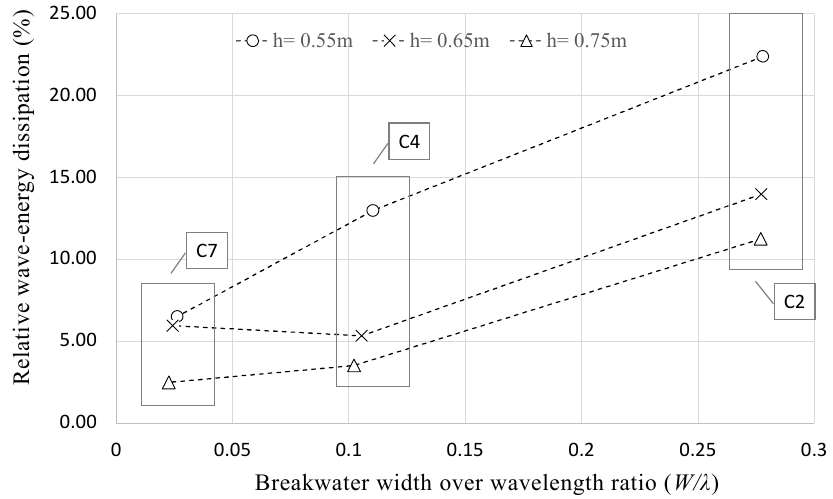
Figure 11. Relative wave-energy dissipation for Conditions 2, 4 and 7 under the three water depths (0.55, 0.65 and 0.75 m) as a function of breakwater width over wavelength ratio ( W/λ ).